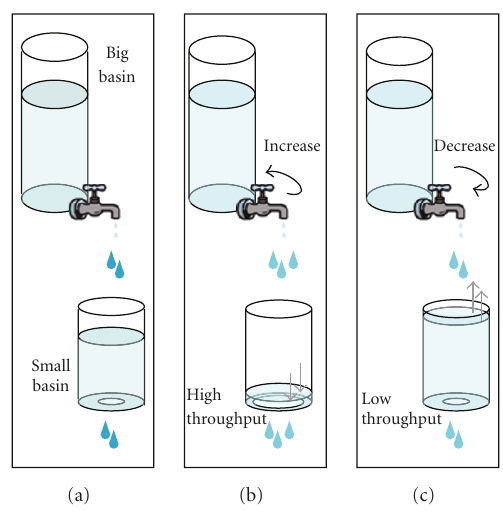
Figure 2: Representation of the TCP